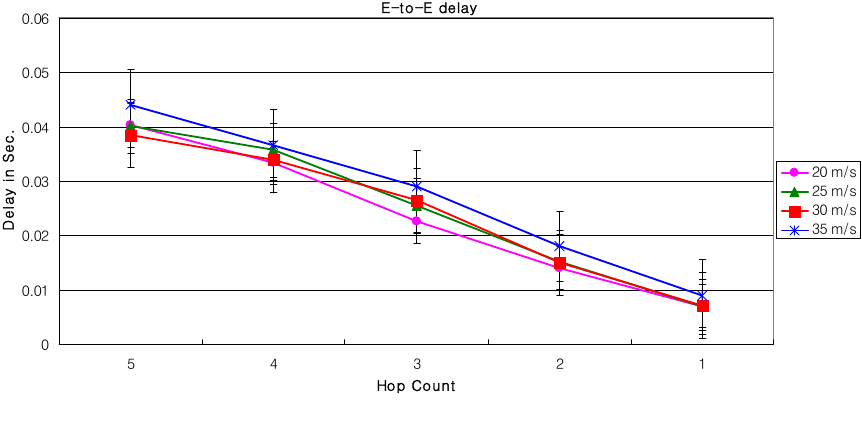
Figure 19. Packet success rate vs. number of hops with variable MN’s speed